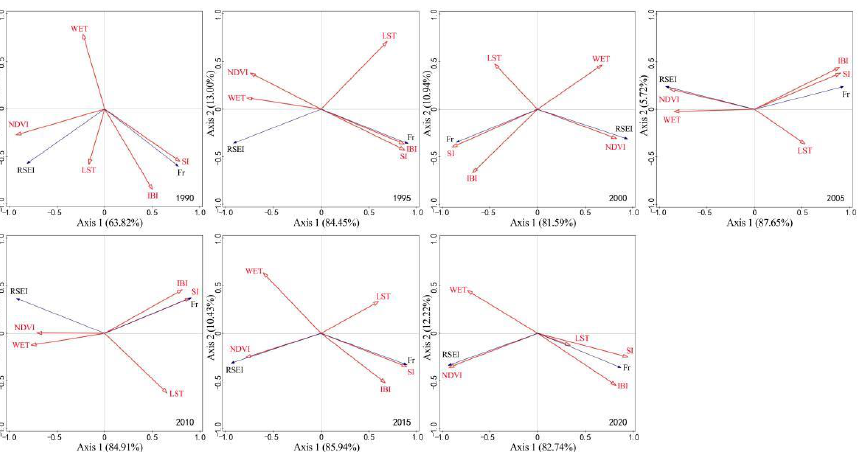
Figure 7. Correlation of RSEI and Fr with modeling factors. Note: RSEI, Fr, NDVI, WET, IBI, SI, and LST respectively represent remote sensing-based ecological index, rock outcrop rate, normalized vegetation index, wetness component, index-based built-up index, bare soil index, and land surface temperature; RSEI and Fr are response variables and the rest are interpretation variables.